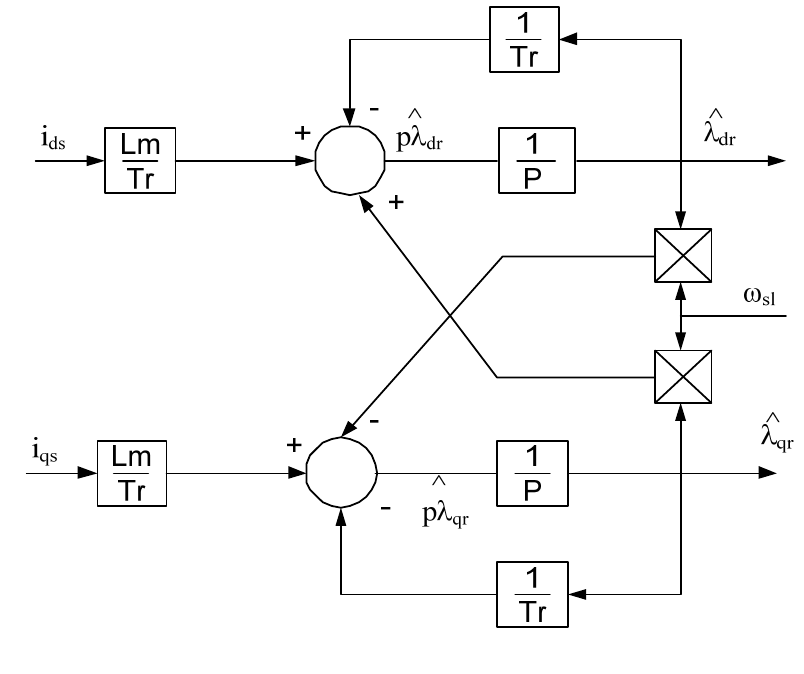
Figure 11. Current model rotor flux observer.